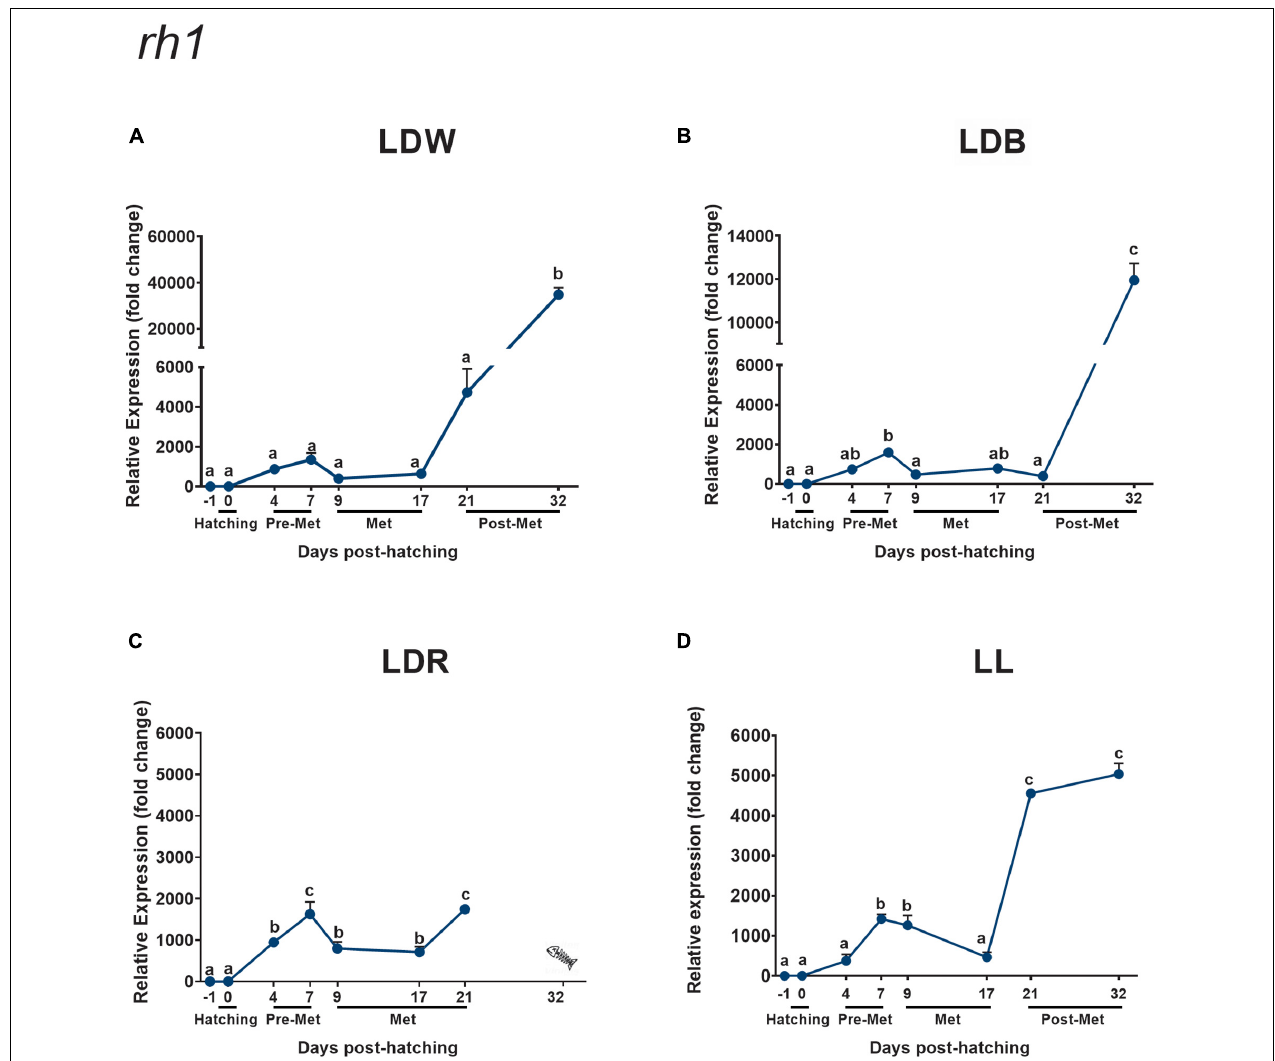
FIGURE 1 | Expression of rod opsin ( rh1 ) in embryos, larvae, and juveniles of the Senegalese sole –1 day post-hatching (dph) or dph –1 (embryos), dph 0 (hatching), dph 4–7 (pre-metamorphosis, Pre-Met), dph 9–17 (metamorphosis, Met), and dph 21–32 (post-metamorphosis, Post-Met) analysed by real-time quantitative polymerase chain reaction (RT-qPCR). It should be noted that the animals under LDR conditions showed delayed development, remaining in the metamorphic phase (S2-middle metamorphosis) on dph 21. Therefore, the bar indicating the metamorphic stage has been extended to dph 21 in panel (C) . Each value represents the mean ± SEM ( n = 3–5). Relative expression was normalised to the dph –1 group, and using ef1a1 and ubq as housekeeping genes. Senegalese sole specimens were maintained under different photoperiods and light spectra: light/dark (LD) cycles of white (LDW; A ), blue (LDB; B ), and red (LDR; C ) lights, or under constant light conditions (LL; D ). Different letters indicate statistically significant differences between mean values ( p < 0.05). The Fishbone symbol in the LDR condition indicated that larvae died before the completion of